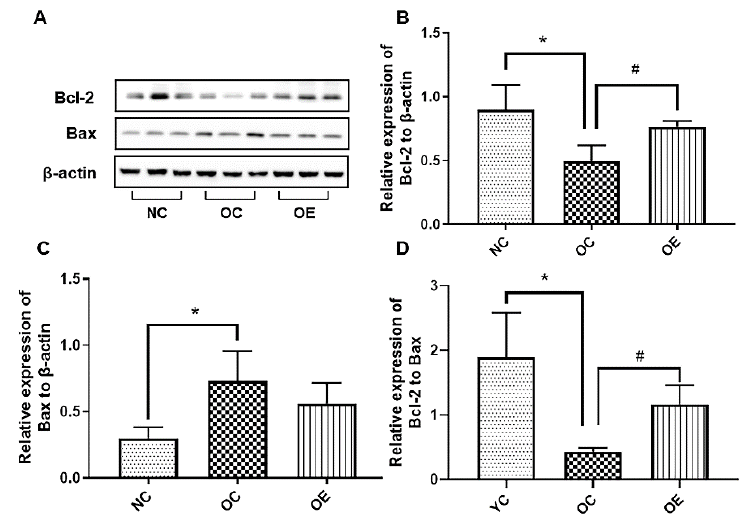
Figure 7. The Western blot of proteins associated with apoptosis ( A ) and corresponding statistical analysis of Bcl-2 ( B ) and Bax ( C ) expression levels, as well as Bcl-2/Bax ( D ) in hippocampal tissues of the mice. All data were presented as mean ± standard deviation (M ± SD) ( n = 3 mice per group). Compared with the NC group, * p < 0.05; compared with the OE group, # p <